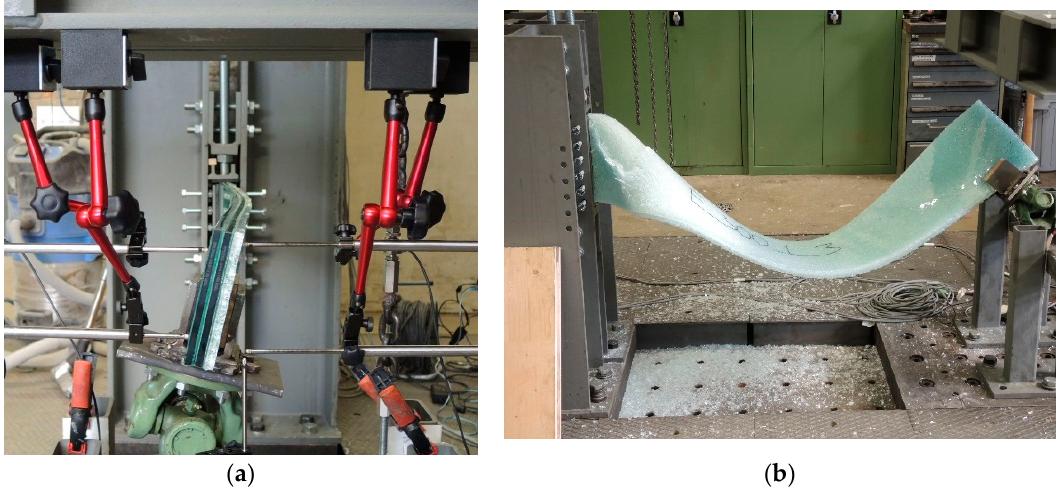
Figure 2. Testing device and procedure exemplary for a fully tempered (FT) glass panel: ( a ) Failure of the first glass panel, ( b ) total failure of all three panels. Table 2. Measured lateral and rotational imperfections of all test specimens. Lateral Imp. Test Specimen